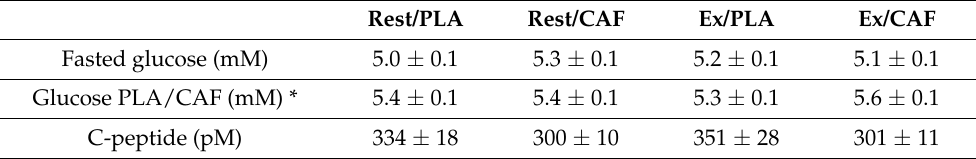
Table 1. Blood glucose and serum C-peptide before the four oral glucose tolerance tests. Rest/PLA Rest/CAF Ex/PLA Ex/CAF Fasted glucose (mM) 5.0 ± 0.1 5.3 ± 0.1 Glucose PLA/CAF (mM) * C-peptide (pM) 334 ± 18 300 ± 10 351 ± 28 301 ± 11 Data and mean ± SEM. Abbreviations: Rest/PLA and Rest/CAF: No exercise the days before and placebo or caffeine before OGTT, respectively. Ex/PLA and Ex/CAF: Exercise the days before and placebo or caffeine before OGTT, respectively. Glucose CAF/PLA: Blood glucose 30 min after intake of placebo or caffeine. *: Two-way ANOVA; Time effect ( p =